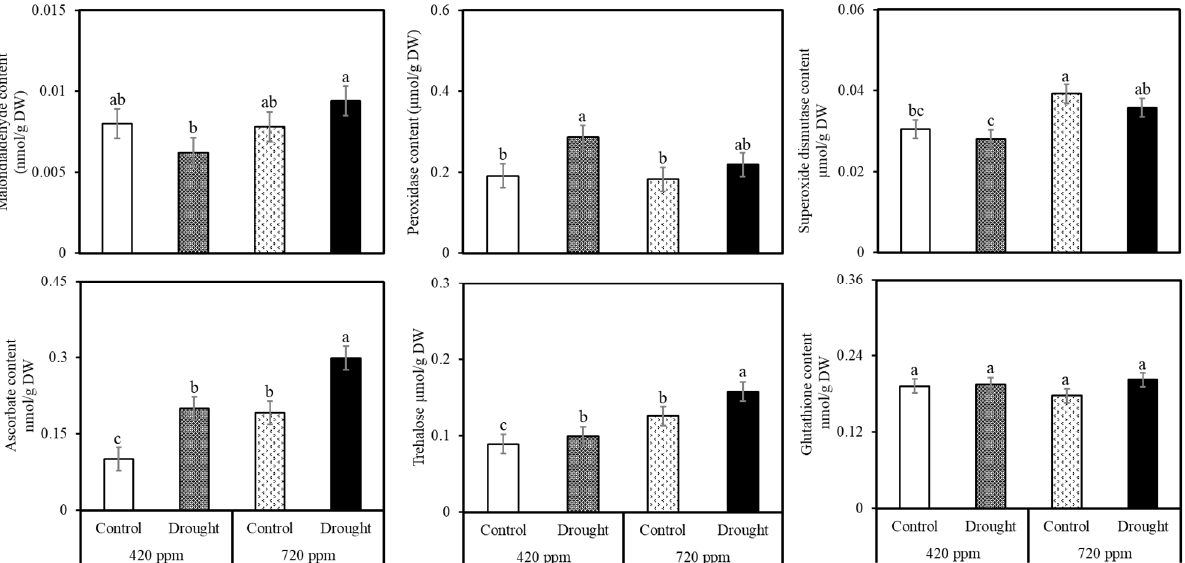
Figure 4. Malondialdehyde (MDA), peroxidase, superoxide dismutase (SOD), ascorbate, trehalose, and glutathione esti- mation of basil plants grown under without drought stress (control) and with drought stress at two levels of CO 2 (420 and 720 ppm) after 17 days of treatment. Data are presented as treatment means ± SE ( n = 10). Different low case letters indicate a significant difference at p < 0.05 by the least significant difference.